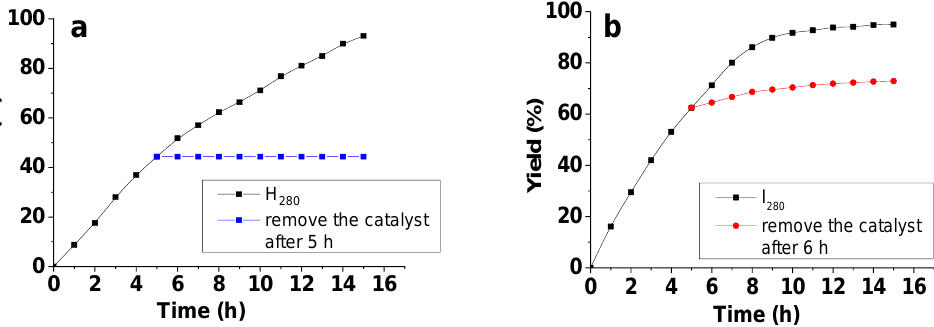
Figure 13. Heterogeneous test for Ni NPs@PPP prepared at 280 °C by the “heat - up” approach (H 280 , a ) and prepared at 280 °C by the “injection” approach (I 280 , b ).